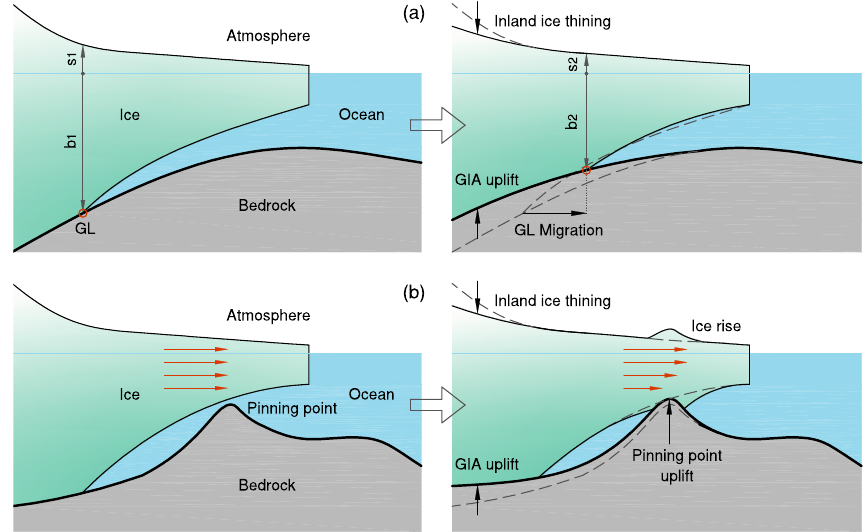
Figure 1. Schematic of IS/SE feedbacks. (a) GL migration controlled by the local sea depth. For equilibrium sea level, the GIA uplift due to thinning of the inland ice promotes the GL migration towards the continental shelf. The hydrostatic equilibrium requires that s 1 /b 1 = s 2 /b 2 = − (ρ w − ρ)/ρ , where s i and b i are the surface and bedrock elevations (subscript i = 1 , 2 represents the initial and final configurations, respectively), and ρ w and ρ are the water and ice densities. (b) Pinning point, raised by GIA uplift due to thinning of the inland ice, provides basal resistance and buttressing to the ice sheet. Red arrows depict the velocity profiles. Dashed lines in the final configurations (second column) represent the initial geometry. Note that the destabilizing effects of GIA during the periods of inland ice thickening that causes the bedrock to subside can be conceptualized by reverting the direction of